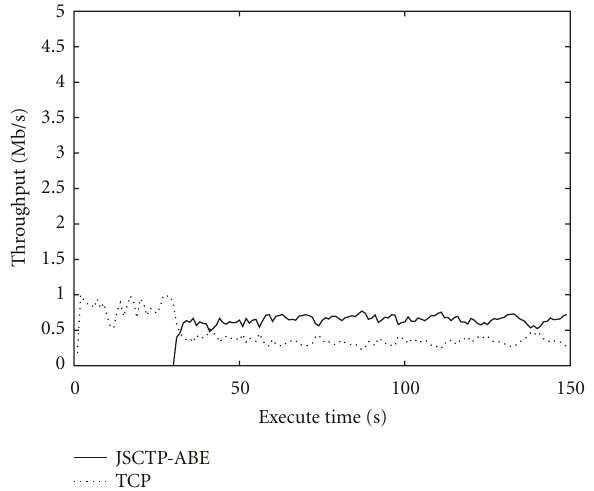
Figure 15: 1% loss rate of TCP friendliness with 5 Mb bottleneck.